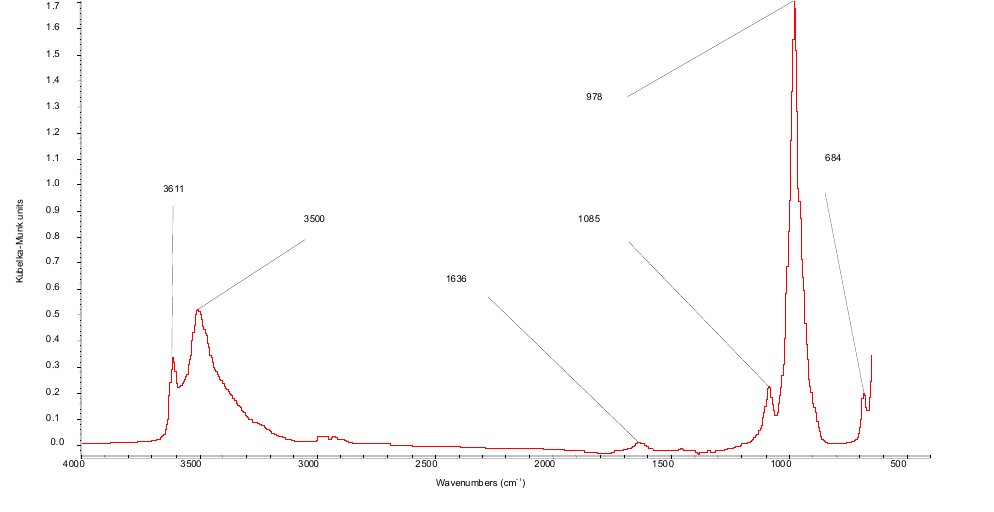
Figure 1. DRIFTS spectrum of vanadium phosphorous oxide (VPO) slurry in THF after drying in a stream of nitrogen.